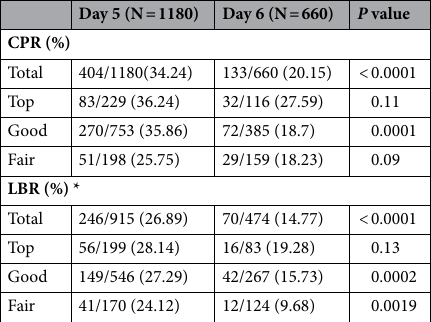
Table 2. Clinical outcomes of day 5 blastocysts vs. day 6 blastocysts ET’s, All. Data is presented in mean ± standard error or percentage. CPR—clinical pregnancy rate, *LBR—live birth rate, derived from ET before 2/2019.